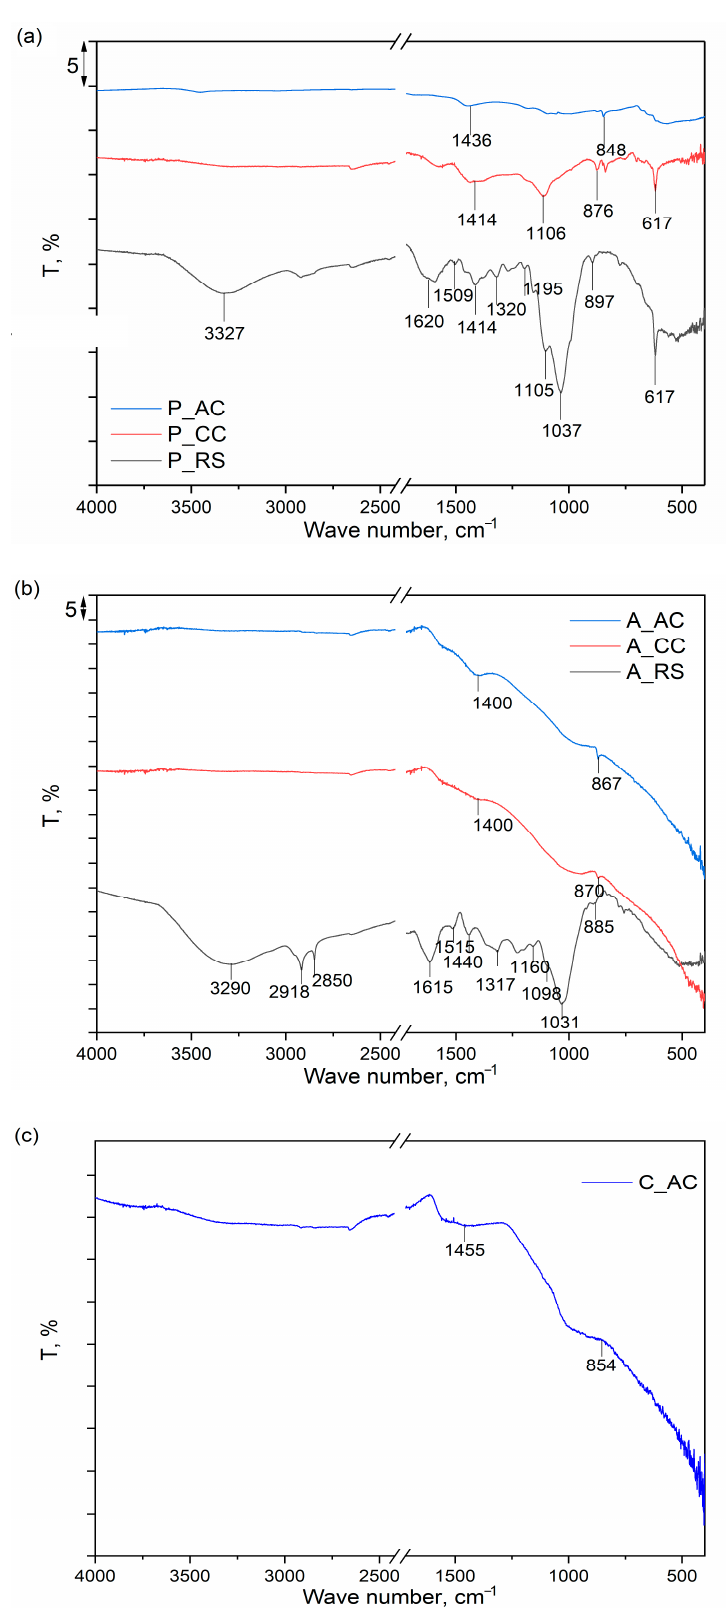
Figure 3. FTIR spectra of the: ( a ) raw (P_RS), carbonized (P_CC), and activated (P_AC) dried palm leaf stalk sample; ( b ) raw (A_RS), carbonized (A_CC), and activated (A_AC) black alder cone-like flowers; ( c ) commercial activated carbon (C_AC).